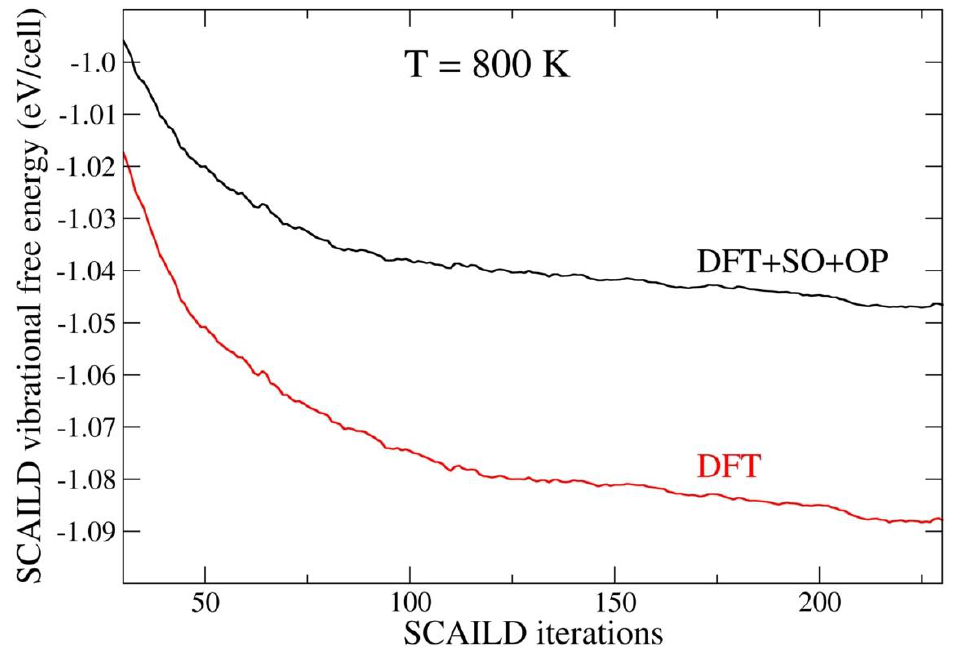
Figure 1. Vibrational free energies (eV/cell) as functions of self-consistent ab initio lattice dynamics (SCAILD) iterations for Vienna ab initio simulation package (VASP)-force calculations that include spin-orbit coupling and orbital polarization (DFT+SO+OP) and not (DFT). The atomic volumes are kept constant and equal to 16.2 Å 3 and 15.6 Å 3 , respectively (see main text). Table 1. Ground-state properties obtained from the full theoretical treatment (DFT+SO+OP) and for a treatment that ignores spin-orbit coupling and orbital polarization (DFT). The atomic volume ( V ) is given in units of Å 3 , while the bulk ( B ), shear ( G ), and elastic ( C ij ) moduli are given in units of GPa. The shear modulus is a Voigt – Reuss –Hill average and the Poisson’s ratio, , is obtained from B and G (see main text).